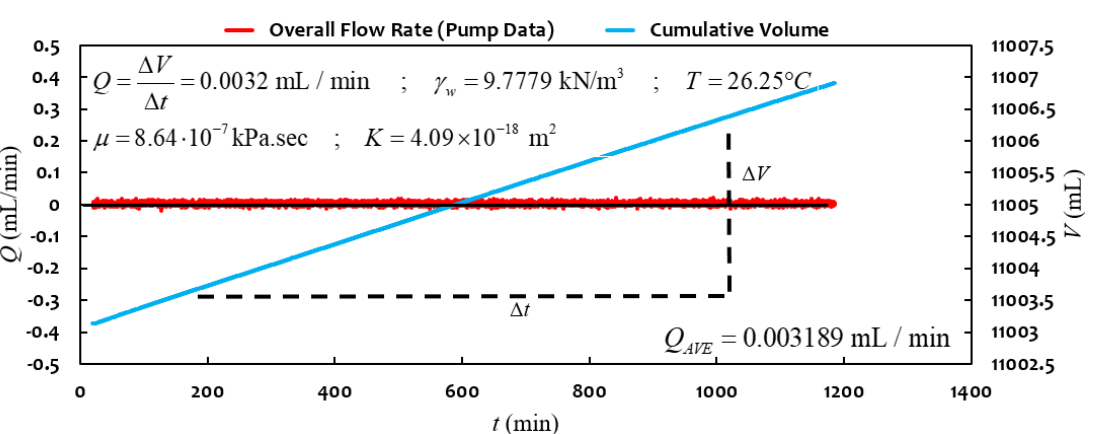
Figure 7. Typical flow rate and cumulative volume records from surface permeability tests conducted on the Stanstead granite cuboid.